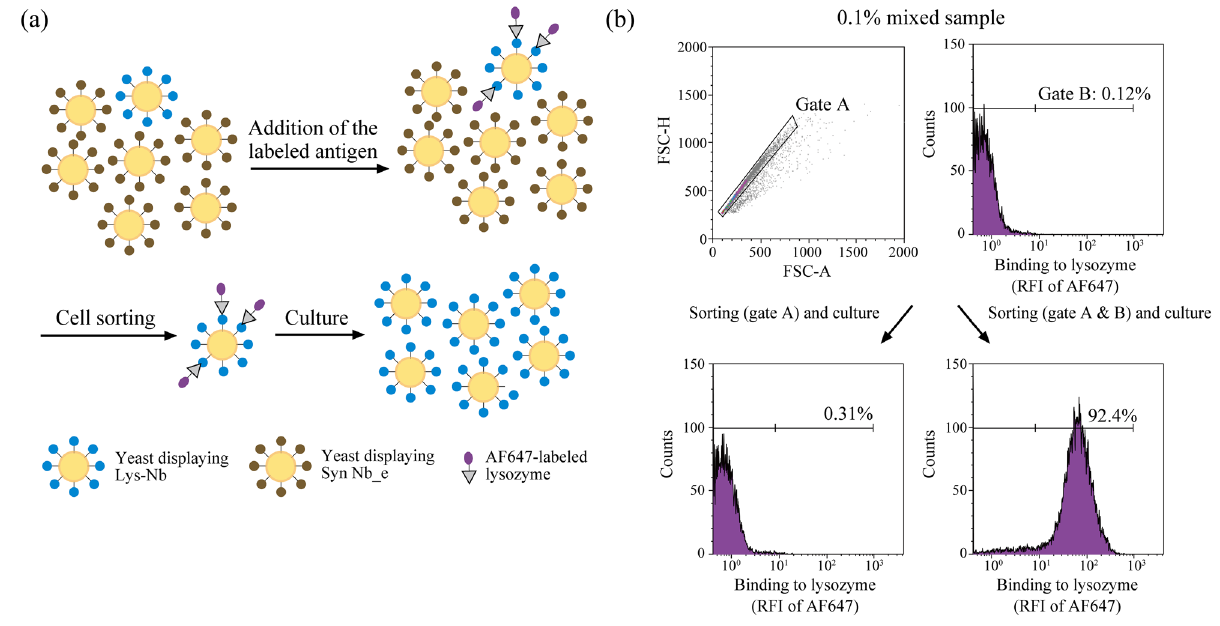
Figure 5. Target cell enrichment by cell sorting. (a) The schematic of nanobody selection. Antigens (grey triangles) are labelled with AF647 (purple circle). Yeast cells displaying nanobodies against the antigen were detected by flow cytometry and isolated via cell sorting. (b) Yeast cells displaying the anti-lysozyme nanobody (Lys Nb) were enriched from the 0.1% mixed culture. Yeast strains producing Lys Nb or nanobody_e from the synthetic library (Syn Nb_e) were co-cultured at the ratio of 1:999. The sample was incubated with AF647- labelled lysozyme and analysed by flow cytometry. AF647-positive (gate B) were sorted and recovered in a selection medium for 72 h. As a control, the singlet yeast cells (gate A) were also sorted and recovered in the same procedure. The recovered yeast cells were stained again with AF647-labelled lysozyme and analysed by flow cytometry. The ratio of yeast cells in the right regions is shown in each graph. The data shown were represented by three independent experiments. RFI relative fluorescence intensity. This figure was created using Illustrator CS2 (https:// www. adobe.